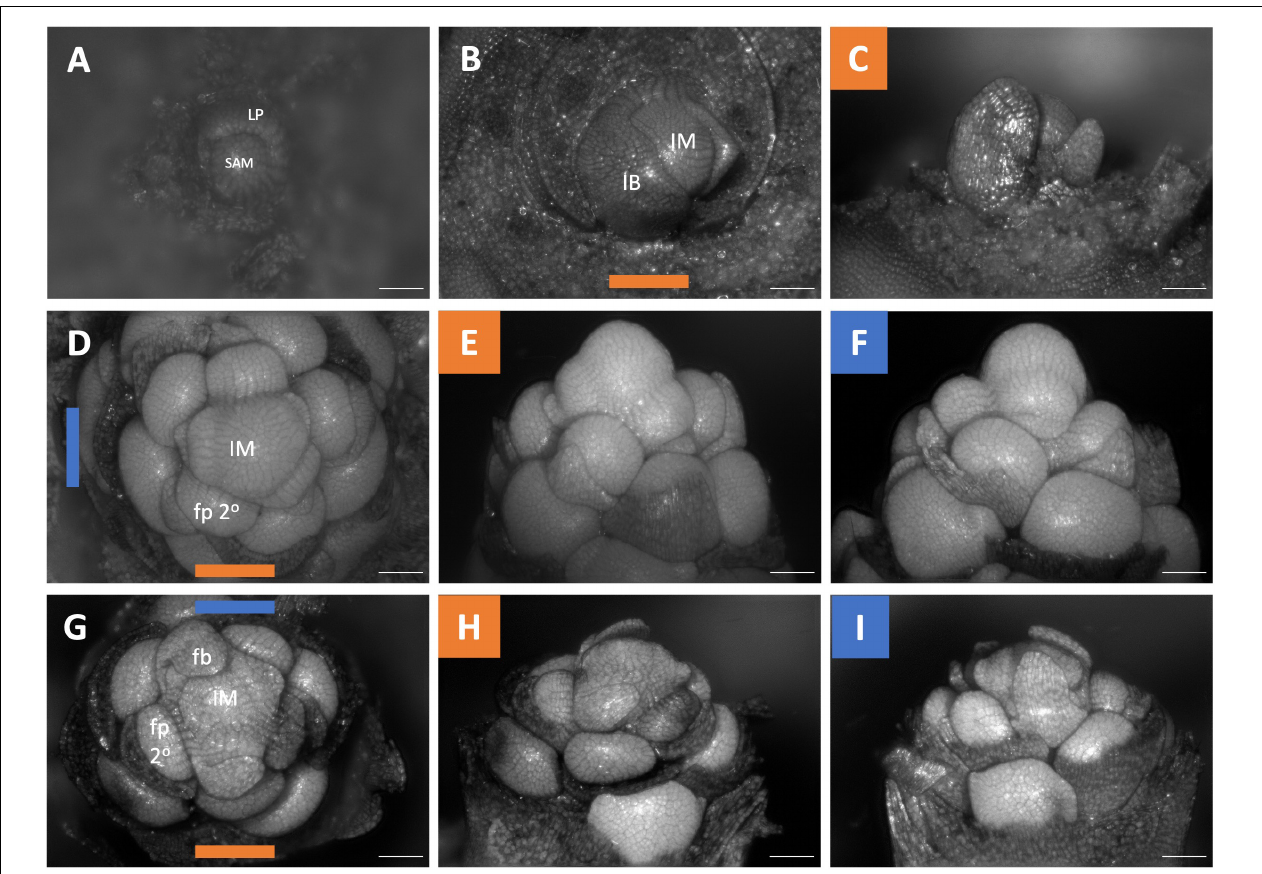
FIGURE 3 | Dichelostemma congestum inflorescence developmental morphology. (A) Shoot Apical Meristem. (B,C) Inflorescence meristem imaged from the apex (B) and laterally (C) . (D–F,G–I) Two stages of inflorescence development, with meristems in the first column (D,G) imaged from the apex and the second (E,H) and third (F,I) columns imaged laterally. Colored lines on images taken from the apex indicate orientation of the inflorescence in subsequent panels [e.g., orange and blue lines in (D) represent orientation of images in (E) (orange) and F (blue)]. Structures only labeled in first apical image. SAM, shoot apical meristem; LP, leaf primordia; IM, inflorescence meristem; IB, Inflorescence bract; FP, floral primordia; fb, floral bract; 2 ◦ –second order flowers. Scale bar of all images: 100 µ